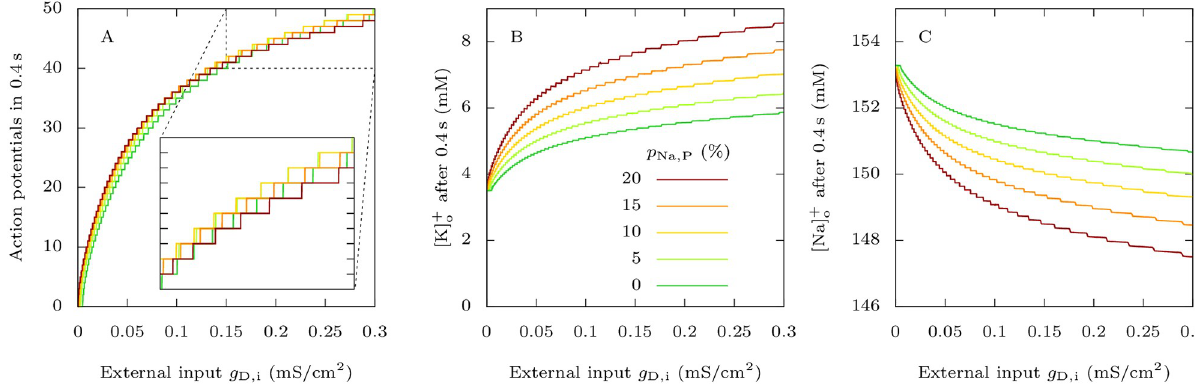
Fig 2. Effect of FHM-3 mutations on the firing properties of the GABAergic neuron. For different values of p Na,P (defined in Section 2.2.6), which we increase to model FHM-3 mutations, we applied to the GABAergic neuron 0.4 s long excitatory external inputs of conductances g D,i . For each p Na,P value, we took as initial condition the steady state in the absence of external input, i.e. when g D,i = 0 mS � cm − 2 . A : Number of action potentials, considered as overshooting spikes (i.e. exceeding 0 mV of peak membrane potential). B : Extracellular potassium concentration at the end of the 0.4 s long simulations. C : Extracellular sodium concentration at the end of the 0.4 s long